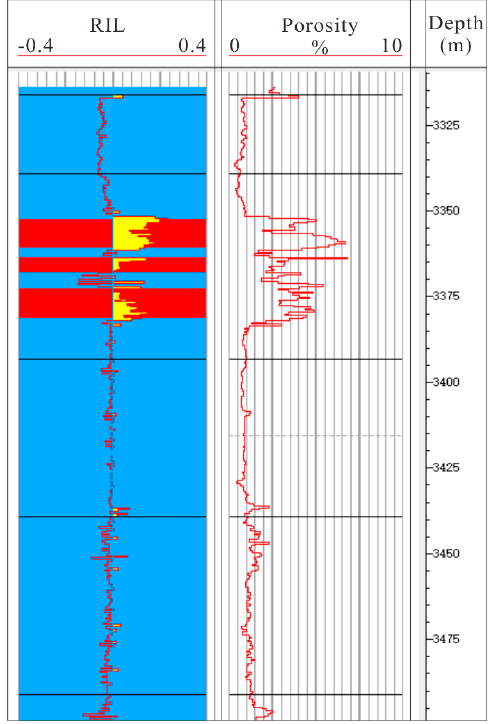
Figure 8. Comparison between the reservior indicator line (RIL) prediction curve and measured neutron porosity curve.